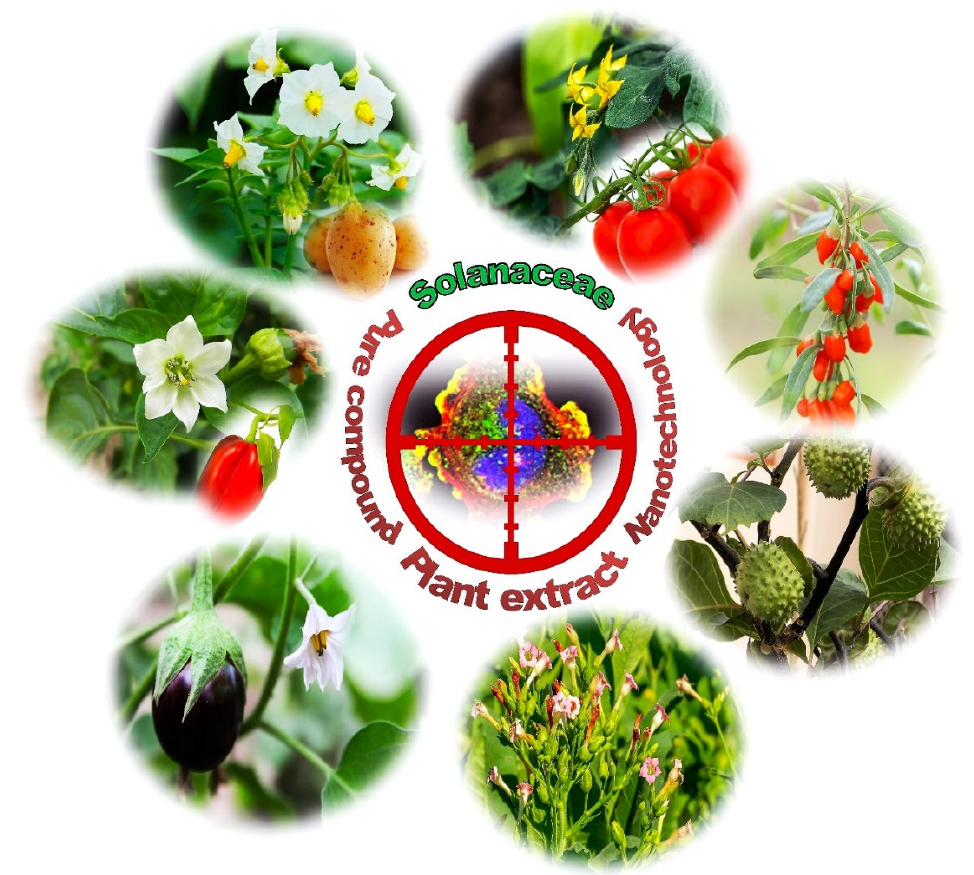
Figure 3. Selected examples of species from the Solanaceae family exhibiting anticancer activity, such as Solanum tuberosum , Capsicum annuum , Solanum melongena , Lycopersicon esulentum , Nicotiana tabacum , Datura stramonium and Lycium barbarum .